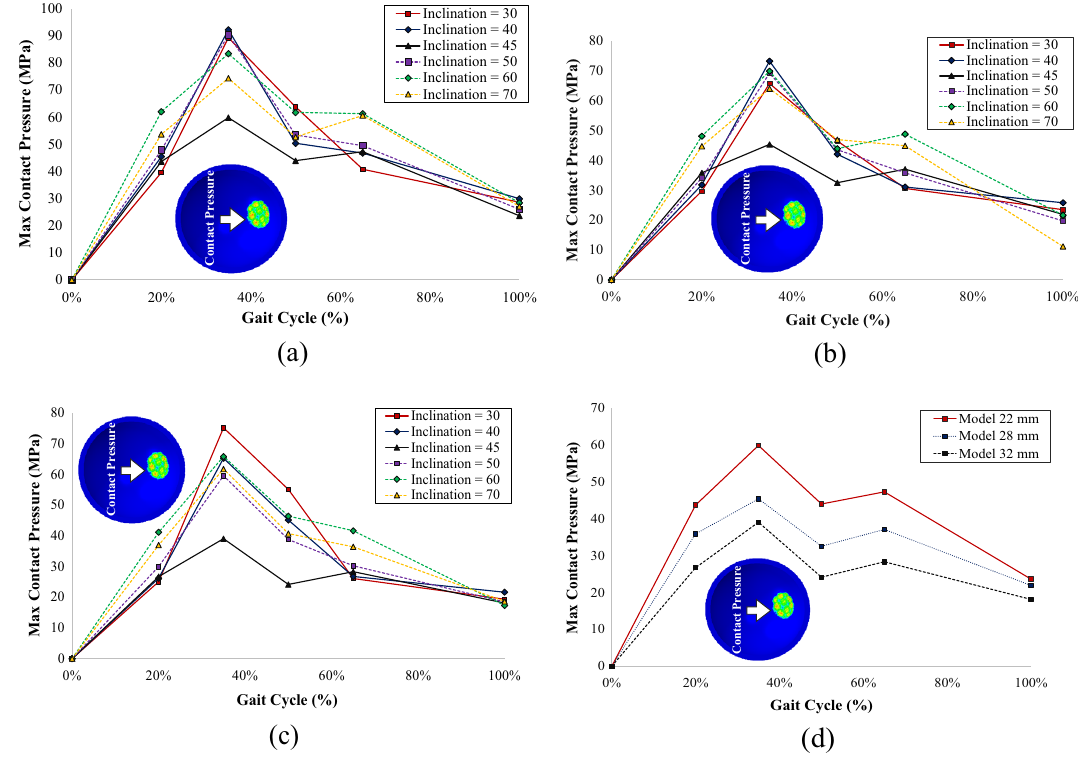
Figure 8. Contact pressure on the inner surface of the acetabular cup: ( a ) model with a 22 mm femoral head, ( b ) model with a 28 mm femoral head, ( c ) model with a 32 mm femoral head, ( d ) contact pressure comparison of different head diameters at the 45° inclination